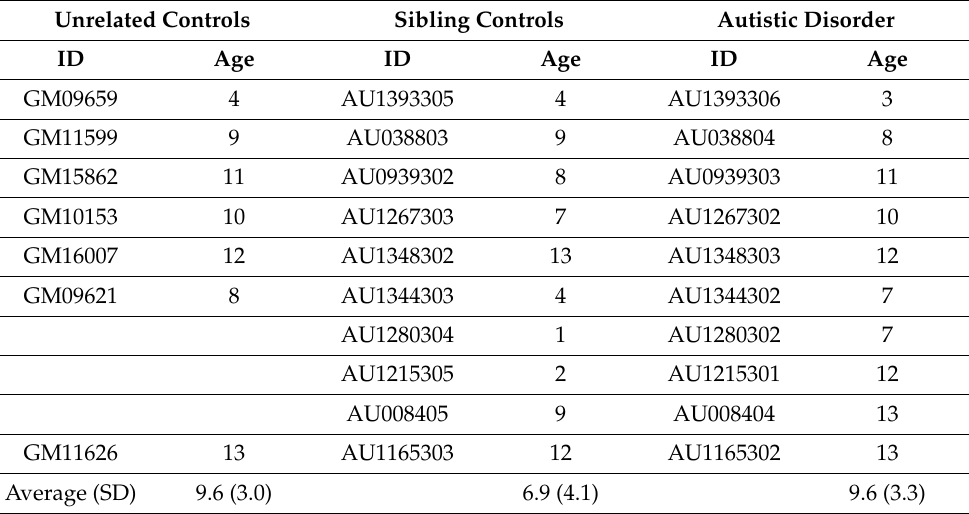
Table 1. Lymphoblastoid cell lines (LCLs) used in this study. LCLs are from children with autistic disorder and typically developing siblings as well as unrelated age- and gender-matched control. The average age of each group is provided. There is no significant difference in age across groups. Unrelated Controls Sibling Controls Autistic